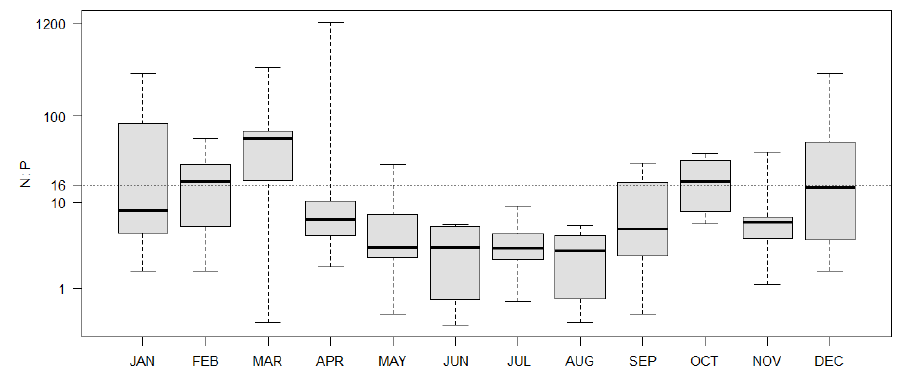
Figure 7. Box plots of monthly molar N : P ratio in deposition samples, showing the third quartile (Q3) and first quartile (Q1) ranges of the data and minimum and maximum of data. For the sake of comparison, the N : P scale is logarithmic and the Redfield ratio is